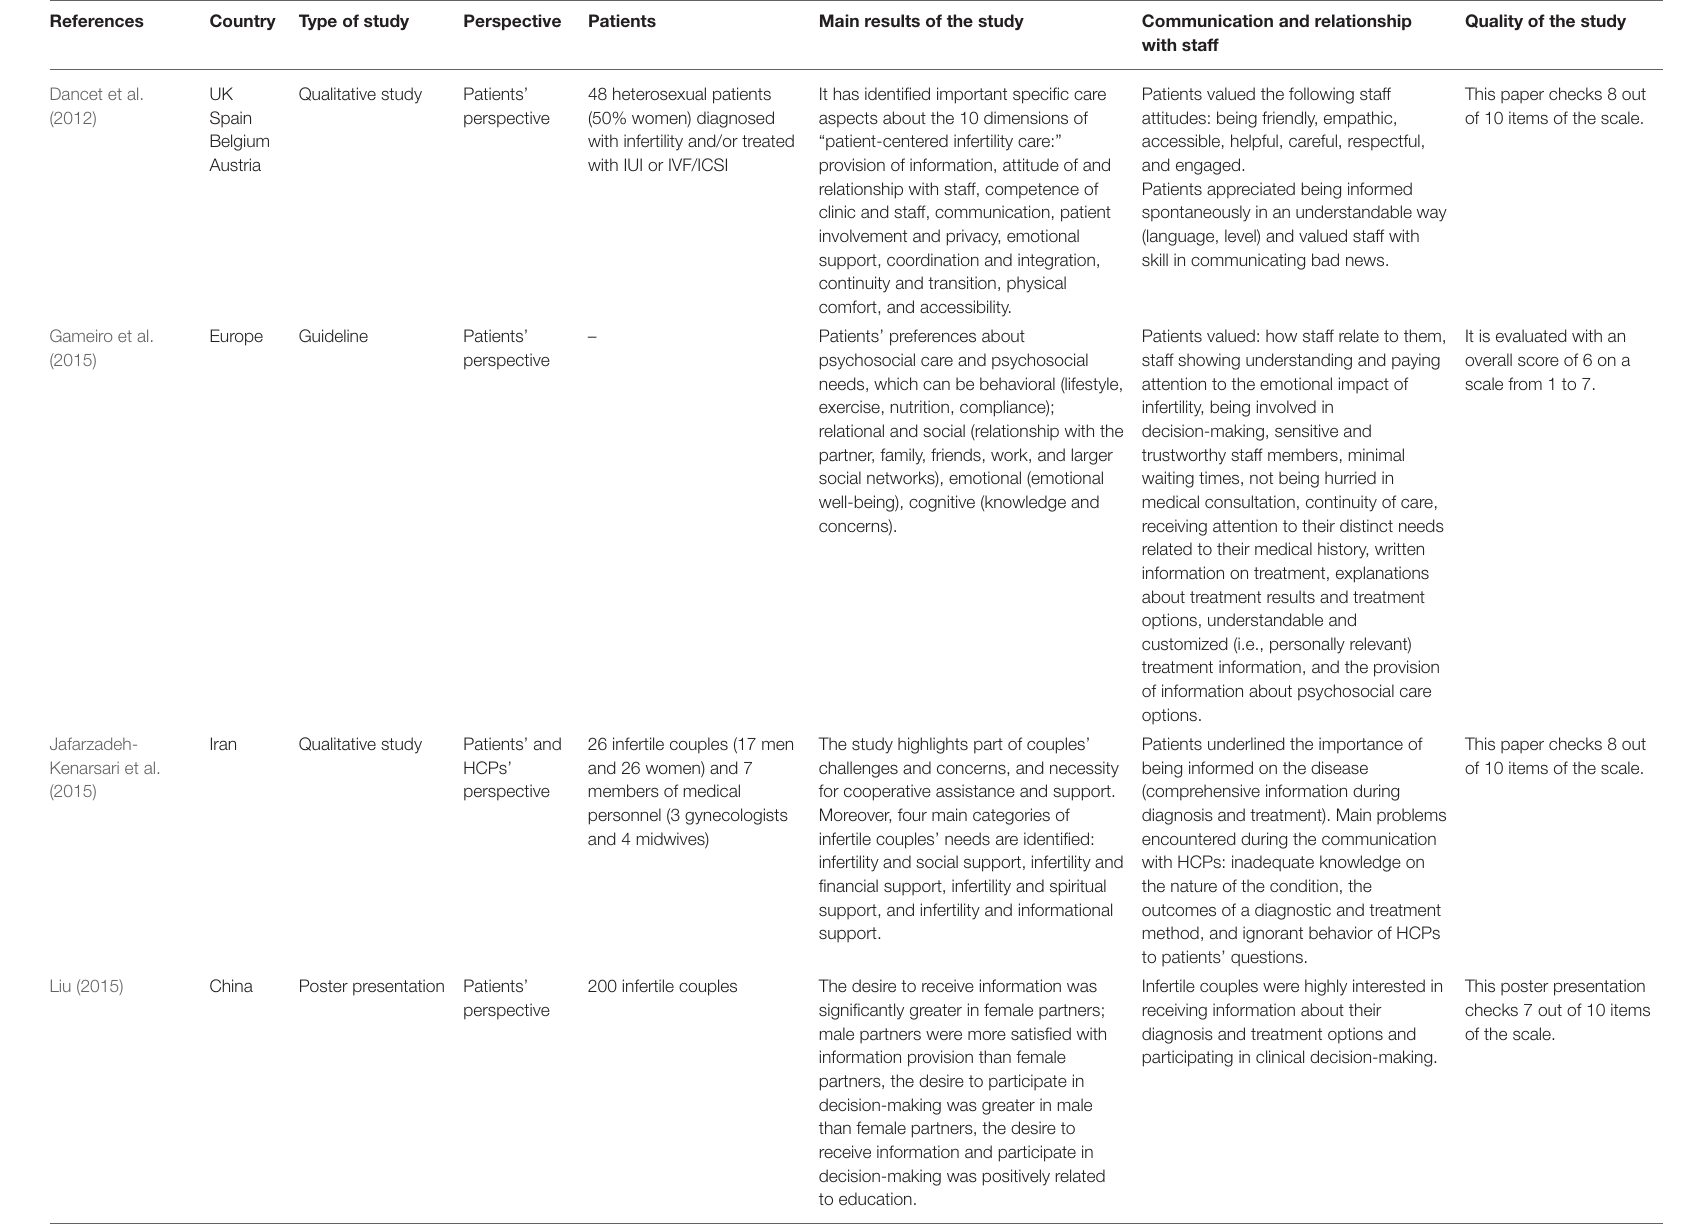
TABLE 1 | Characteristic of included